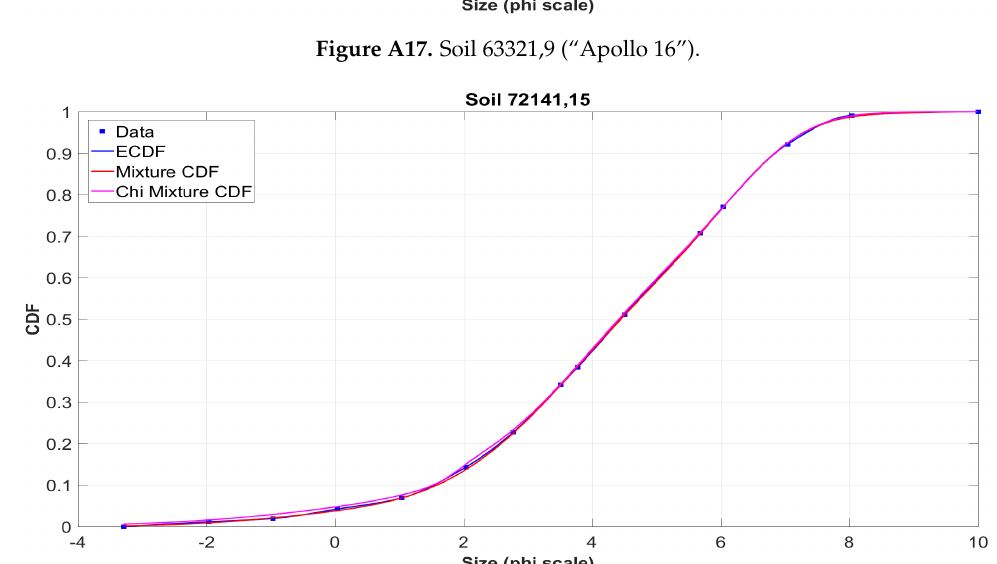
Figure A18. Soil 72141,15 (“Apollo